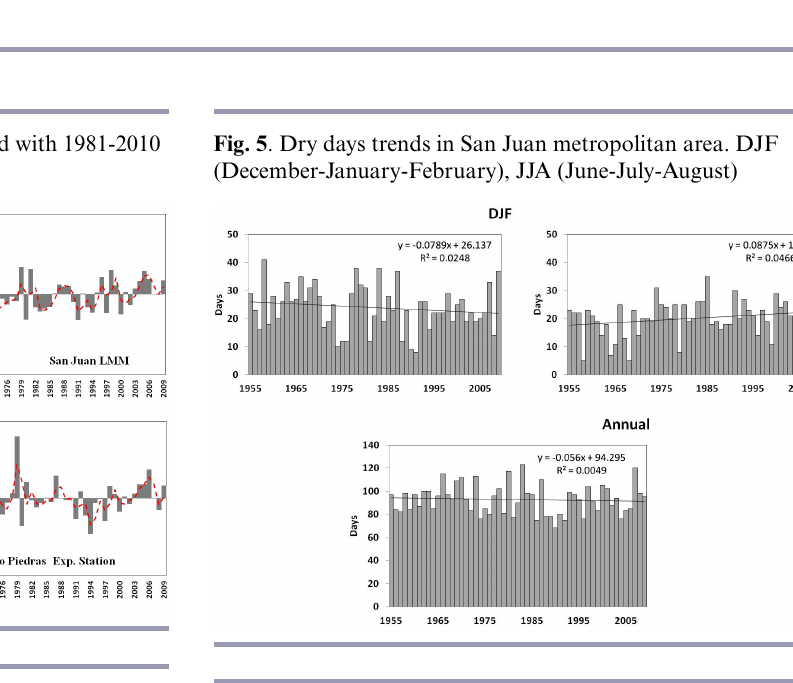
Fig. 4 . Fall histogram with trend lines.